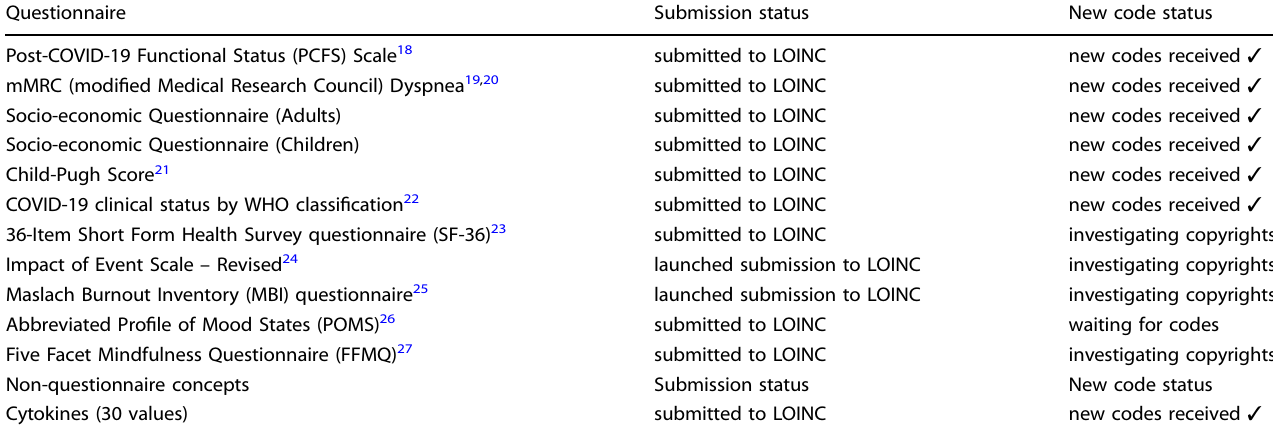
Table 6. Questionnaires and serology concepts used in ORCHESTRA studies that were submitted to LOINC for new code creation.